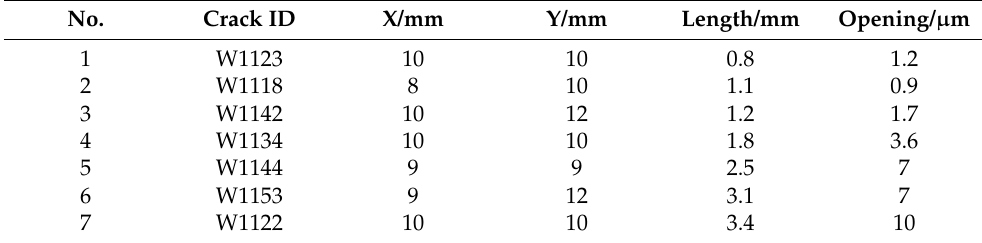
Table 1. List of the cracks in Ti64 alloy, including coordinates (X, Y), length and opening information.